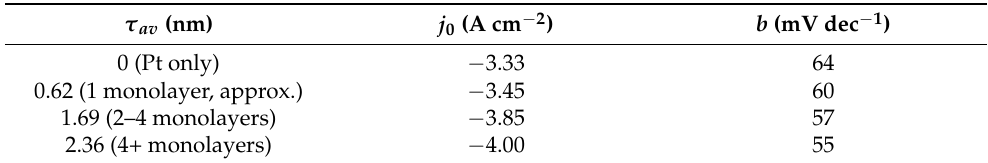
Figure 2. Linear sweep voltammograms (LSVs) in the HER regime with different levels of Cr x O y H z Table 2. Exchange current densities ( j 0 ) and Tafel slopes ( b ) for HER with different thicknesses of Cr x O y H z on